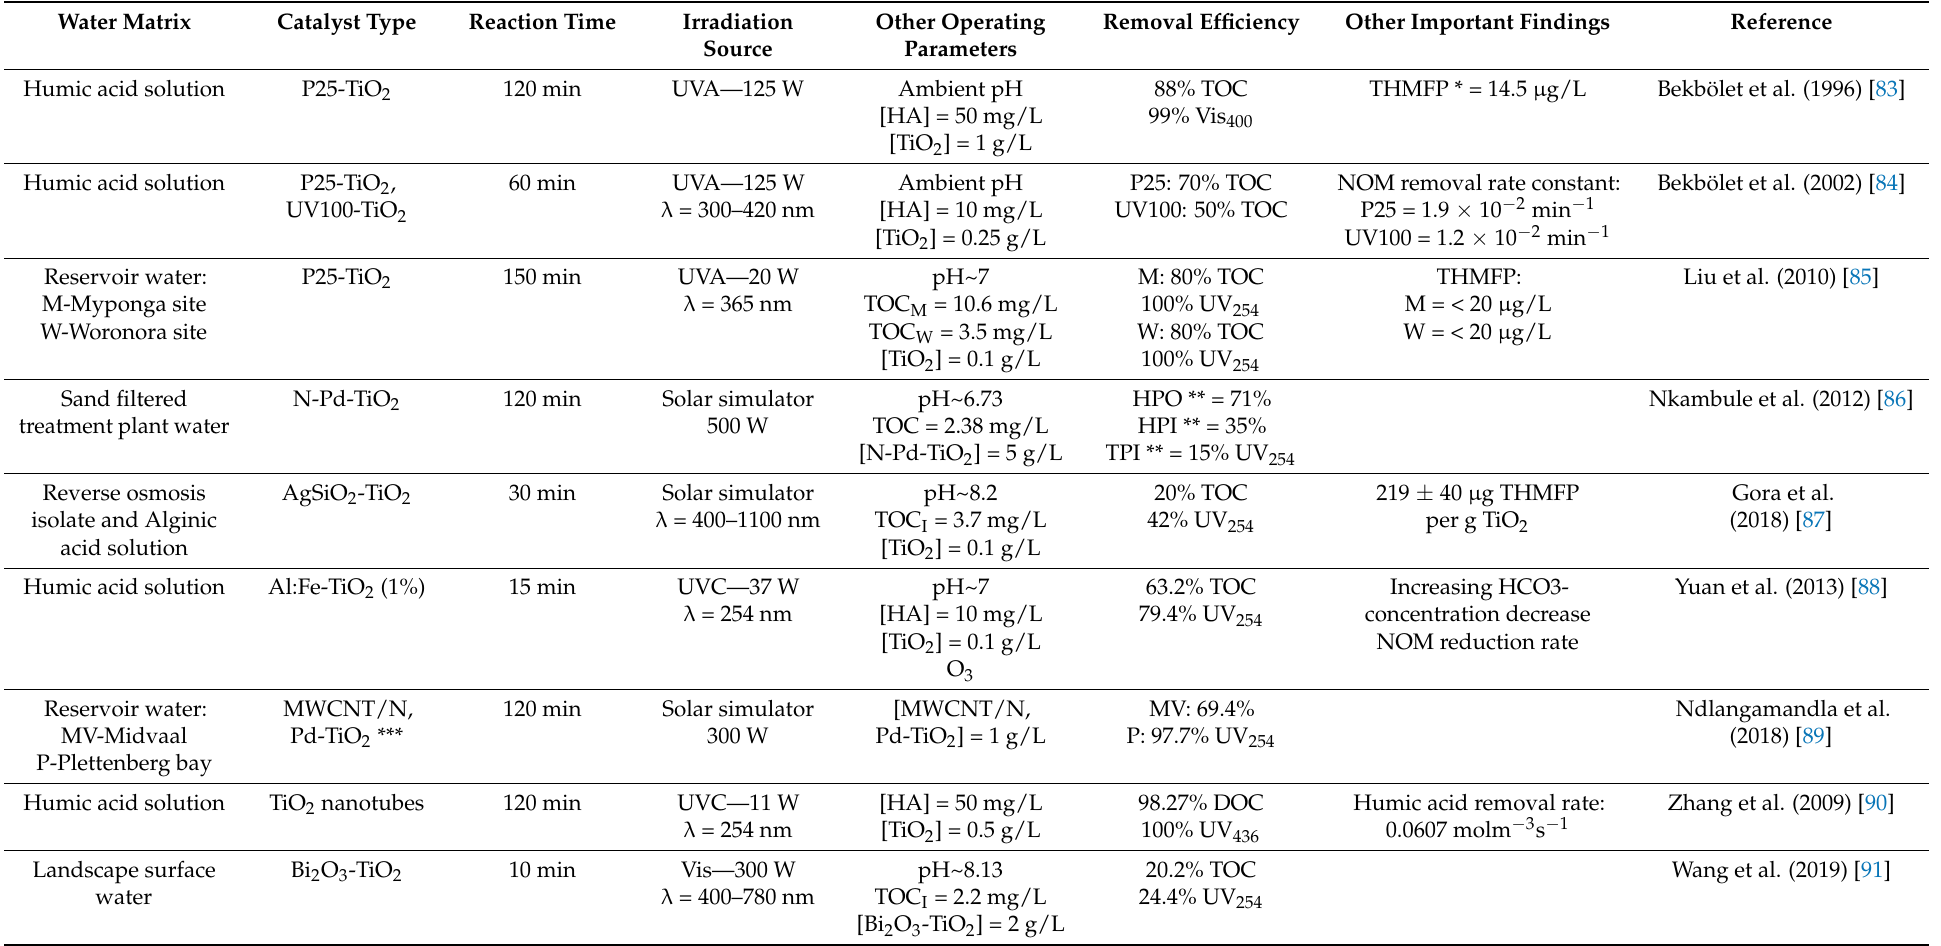
Table 2. Publications on heterogeneous photocatalytic treatment of